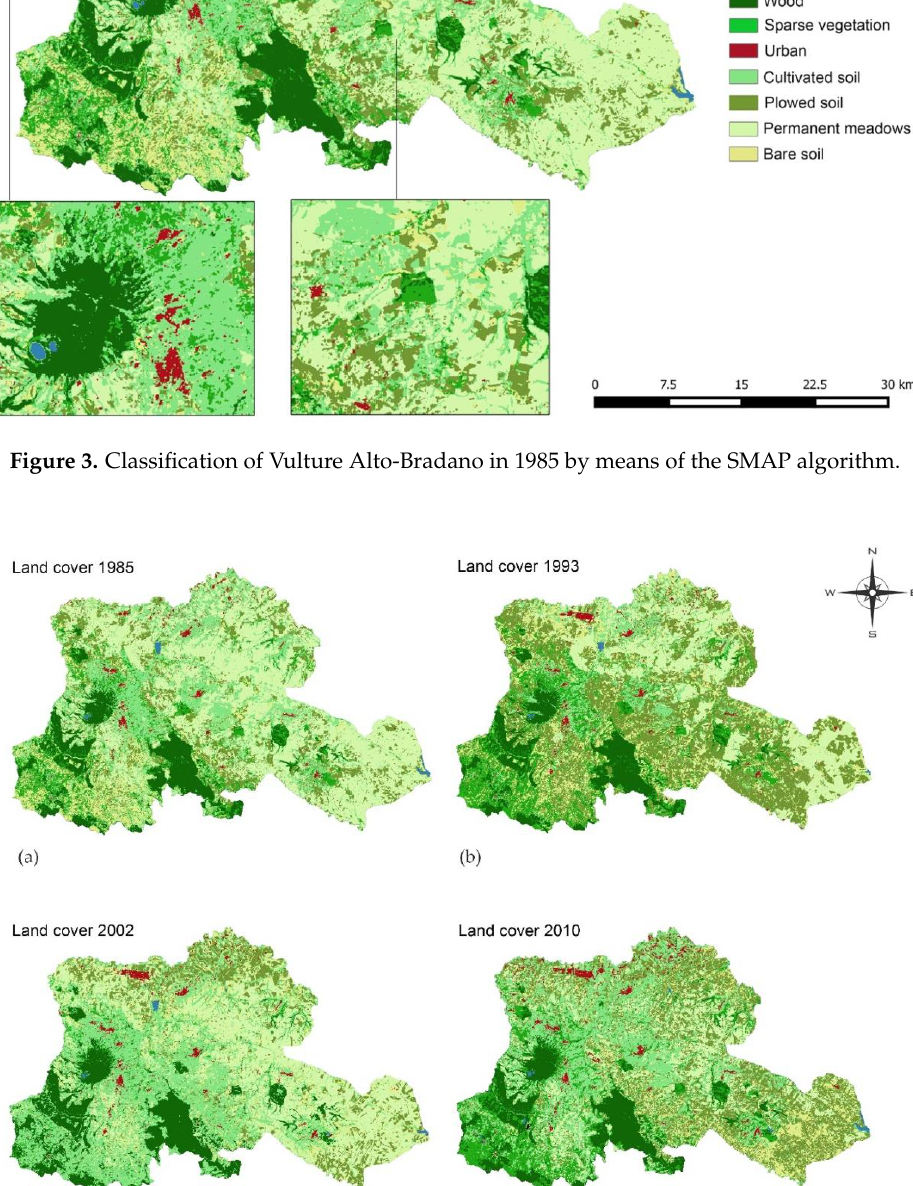
Figure 5. Trend of the spectral signatures of the samples of each cover soil class for the four investigated dates. 3.2. Accuracy Verification From the accuracy verification and observation of the error matrices of each classification, it was possible to highlight the overall accuracy of each classification, as well as the producer’s accuracy, user’s accuracy and K coefficient (Table 3 summarizes the verifications carried out for all four considered dates).